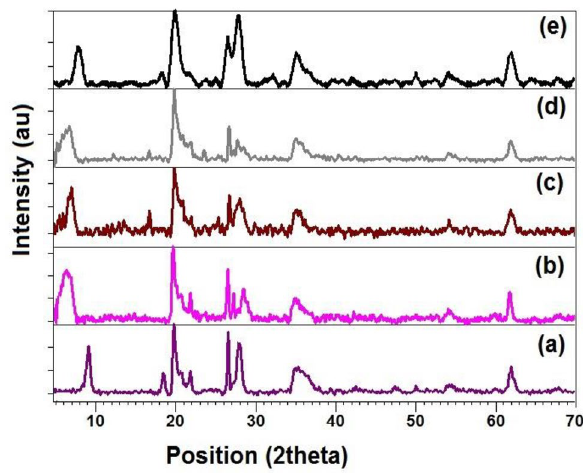
Figure 2. Powder XRD pattern of pristine clay unmodified ( a ), and modified ( b ) B-DSS, ( c ) B-BTC, ( d ) B-BTB, and ( e )